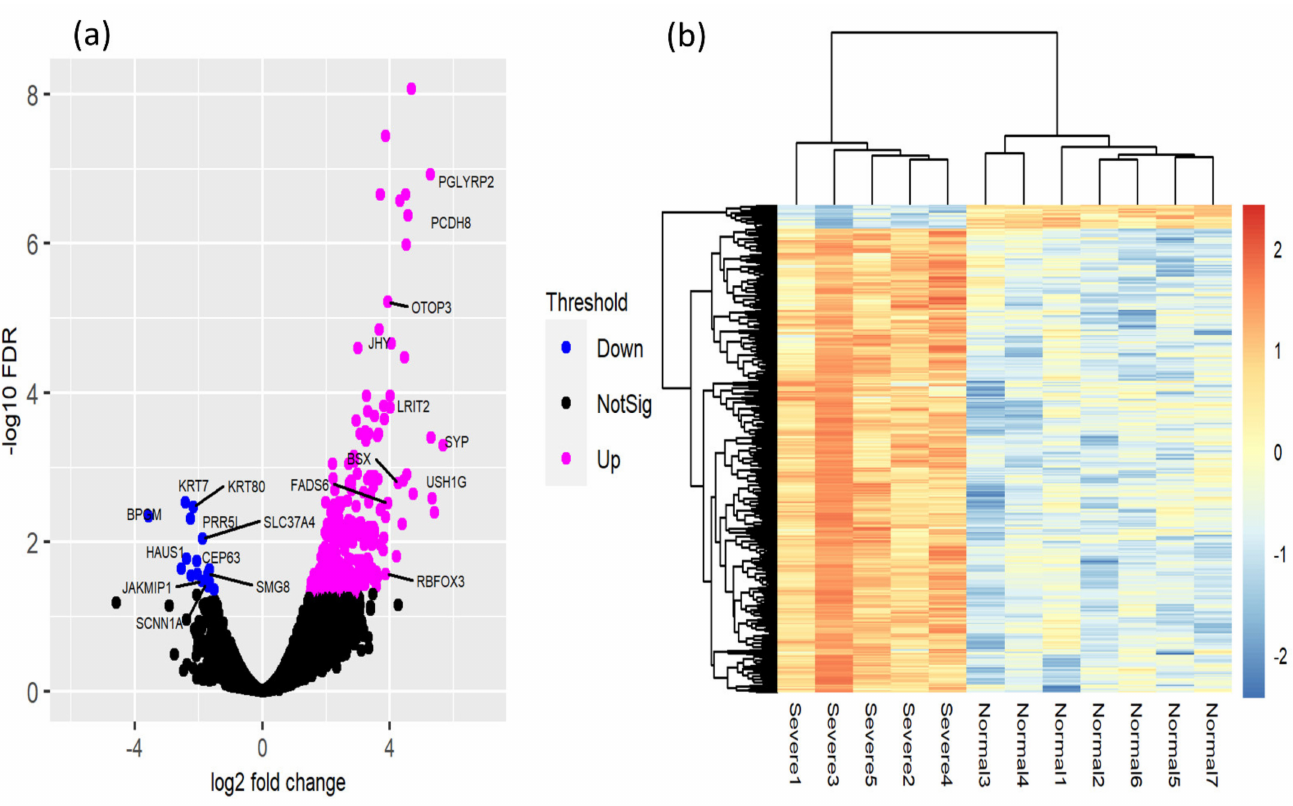
Figure 3. ( a ) Volcano plot showing the detected genes, DEGs, and the top 10 expressed genes involved in regulation between the two groups, ( b ) DEGs heatmap showing the detected DEGs and samples. The red and blue colors of the expression patterns indicate upregulated and downregulated,